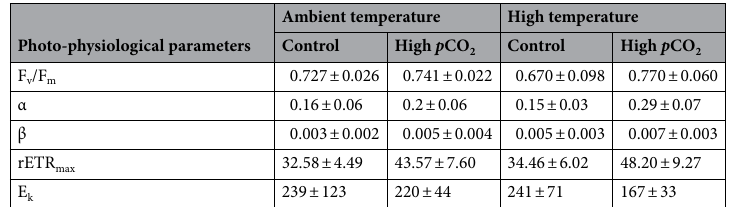
Table 1. Effect of high temperature (+ 3 °C than ambient) and high p CO 2 (1000 µatm) on photo-physiological parameters of seagrass Thalassia hemprichii . Values represent mean ± SD. n = 6.